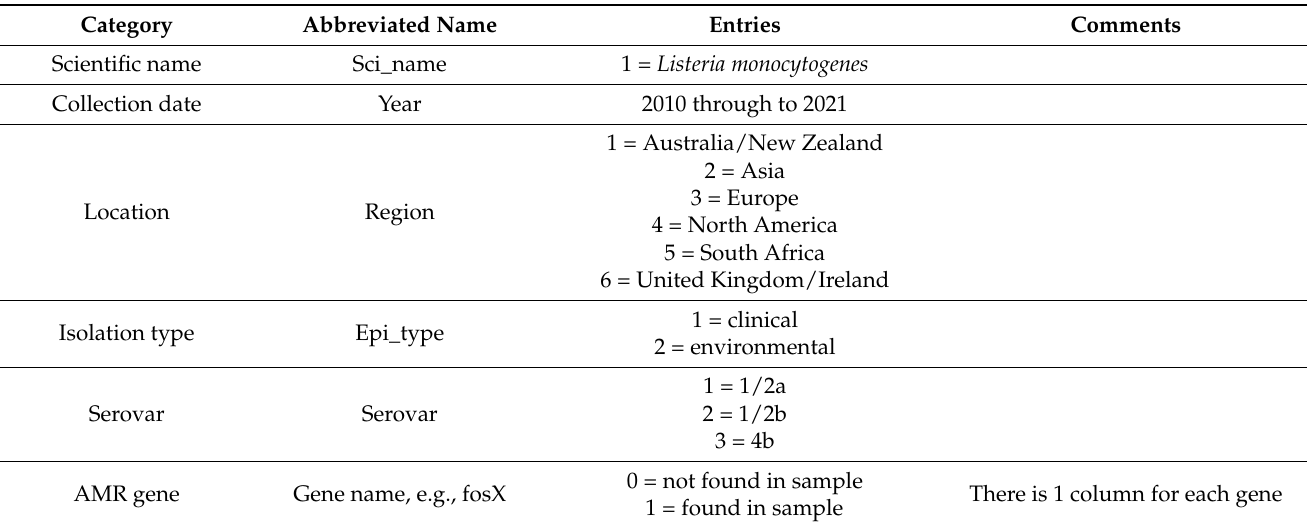
Table 2. Description of processed NPDIB data matrix used for